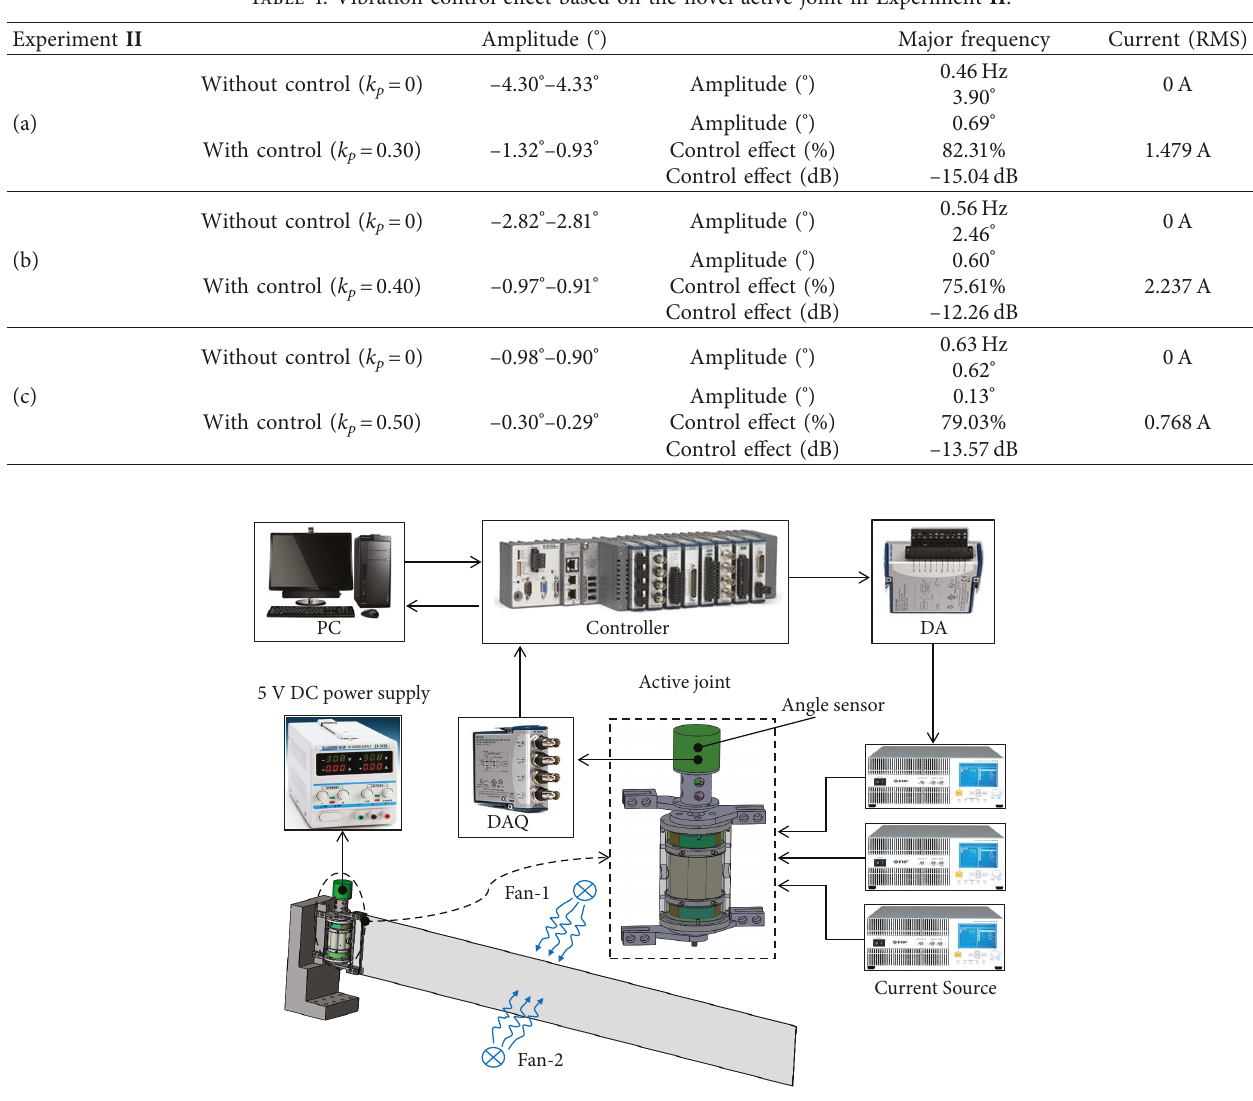
Figure 11: Experimental setup of periodic stimulations based on two fans. Table 5: Varying modes of shaking head fan